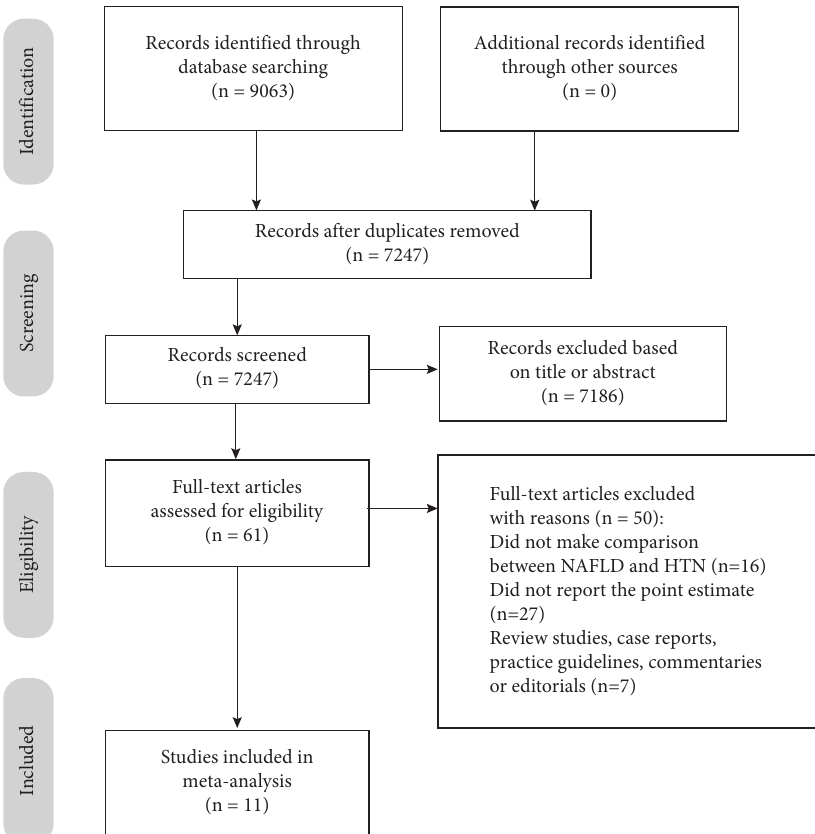
Figure 1: Flow chart of article